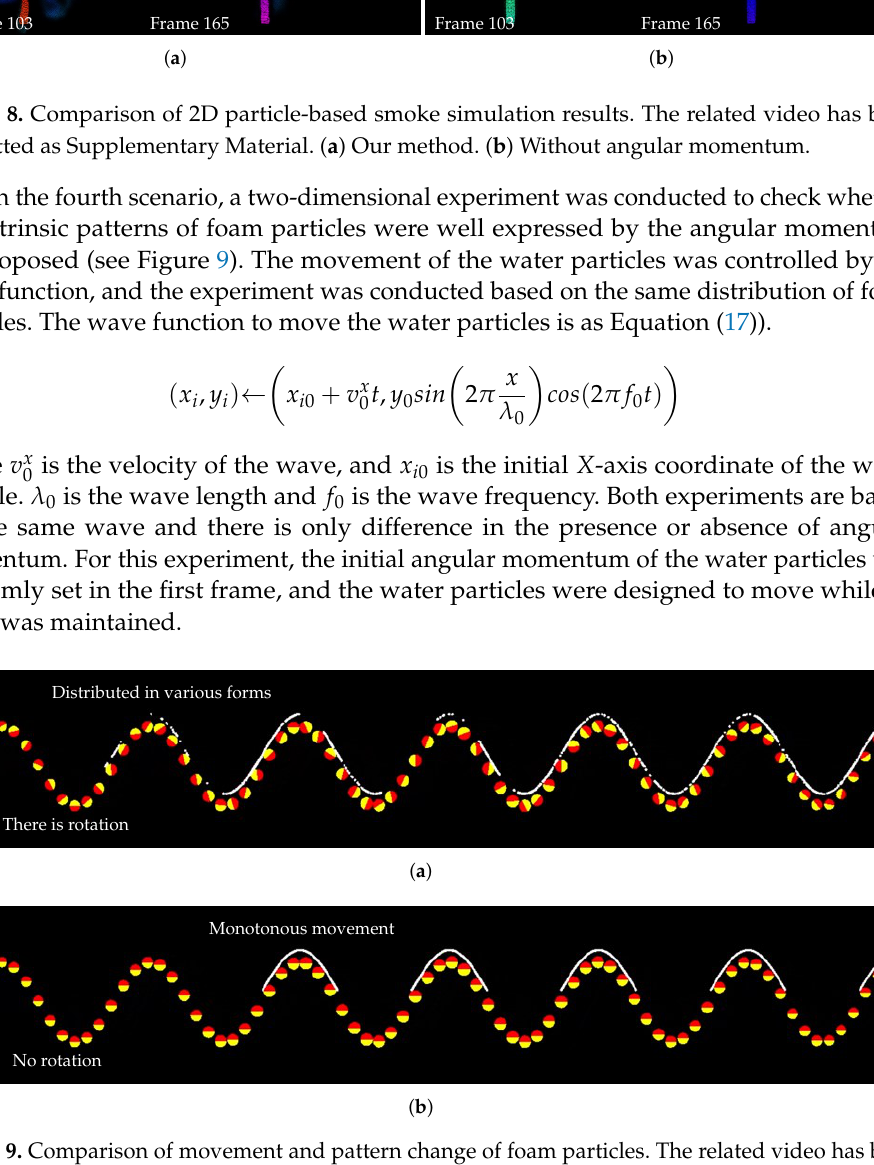
Figure 9. Comparison of movement and pattern change of foam particles. The related video has been submitted as Supplementary Material. ( a ) Our method. ( b ) Without angular